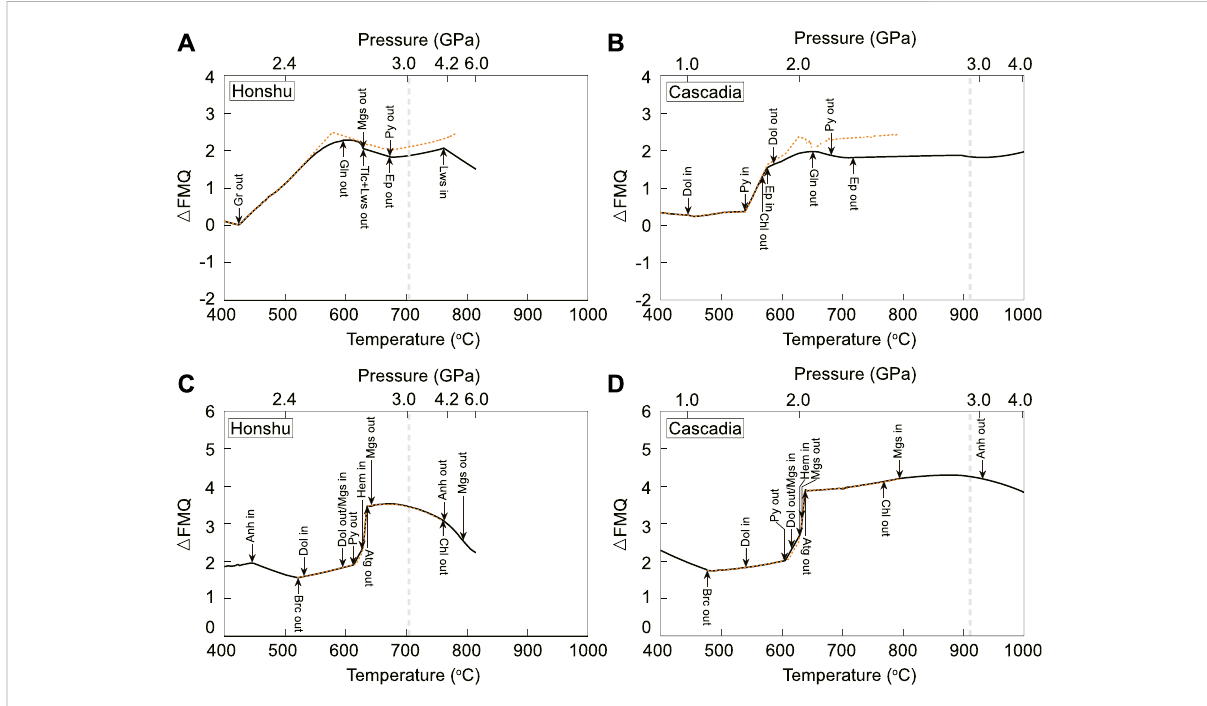
FIGURE 3 fl uids calculated along Honshu and Cascadia geotherms by assuming a closed (solid black f O 2 of AOC (A, B) - and serpentinite (C, D) -derived line) and open system (dashed yellow line), respectively. △ FMQ = log 10 f O 2 — log 10 f O 2,FMQ where FMQ is the fayalite-magnetite-quartz buffer. The stability boundaries of key hydrous minerals and solid C- and S-bearing phases are shown for